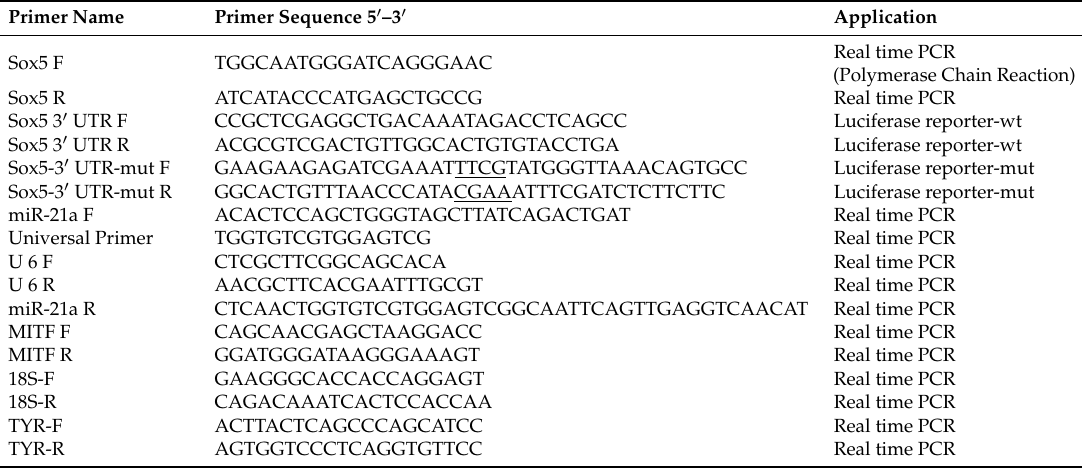
Table 1. Primers used in this study. The underline sequence are mutation